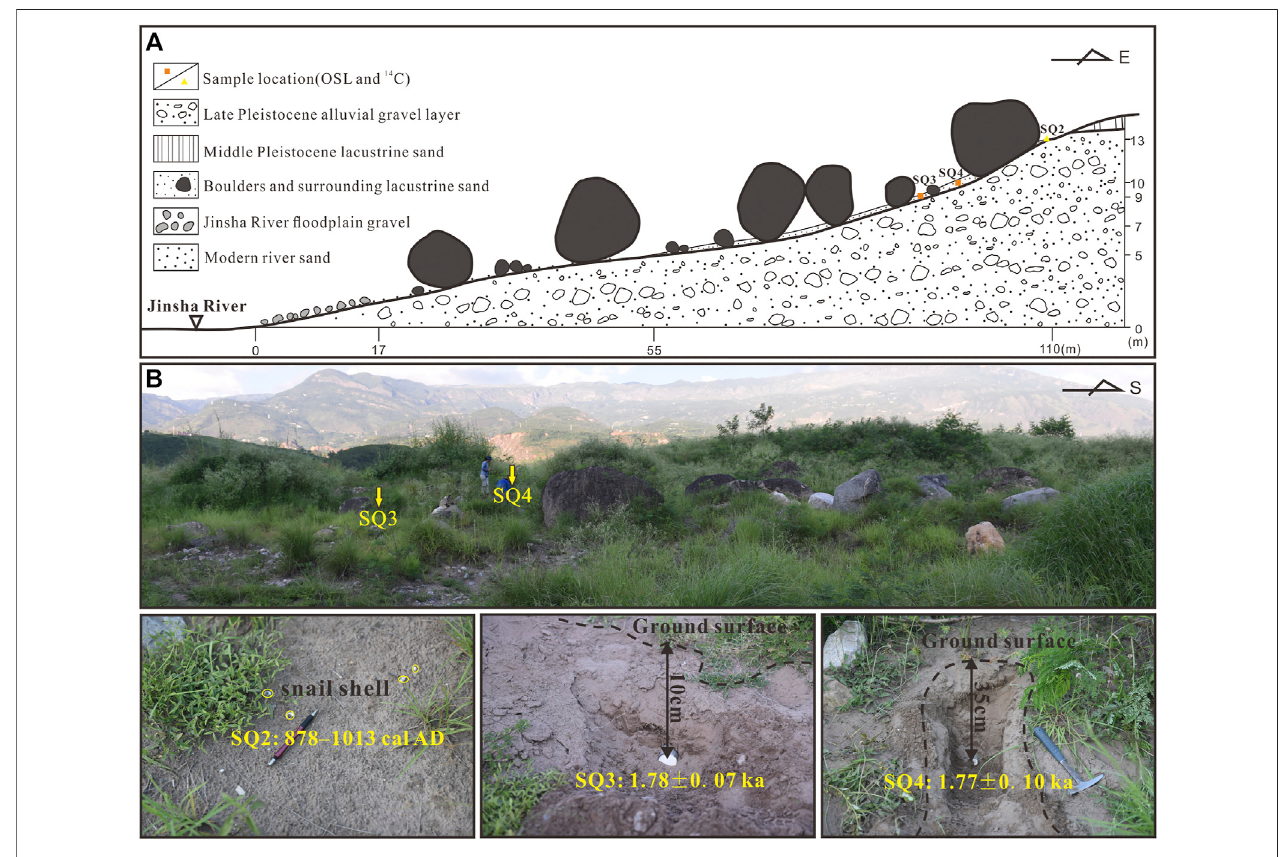
FIGURE 10 | Samples site. (A) Schematic pro fi le of the sampling locations; (B) close-up photos of the sampling locations where one can see boulder sizes, sand, and vegetation cover.